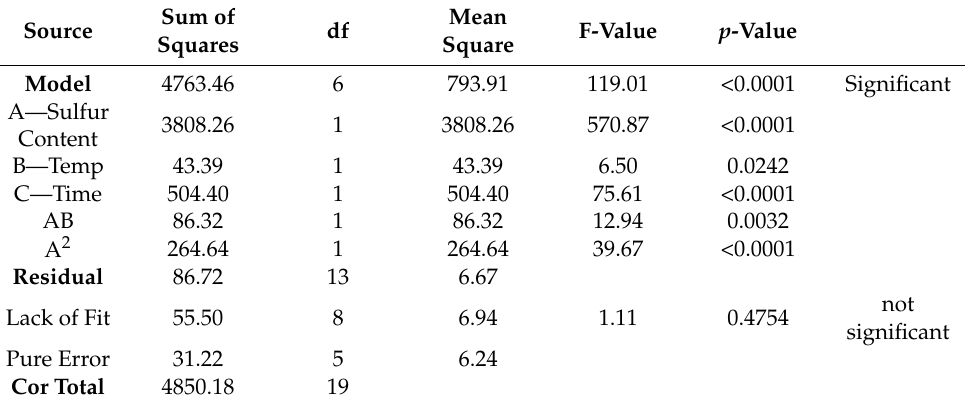
Table 4. ANOVA of the Reduced Model.